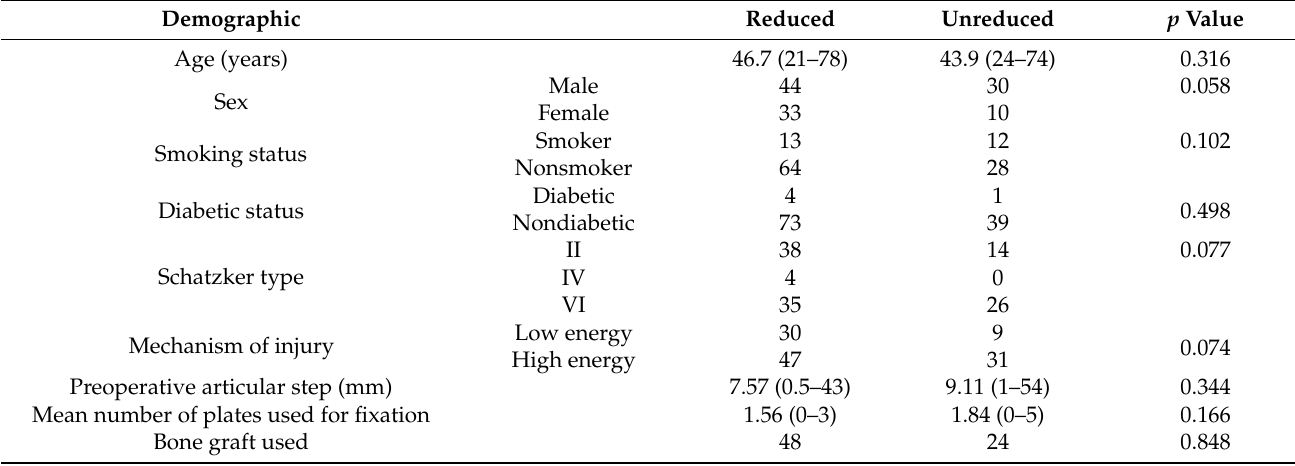
Table 2. Patient demographics and their relationship to fracture reduction.